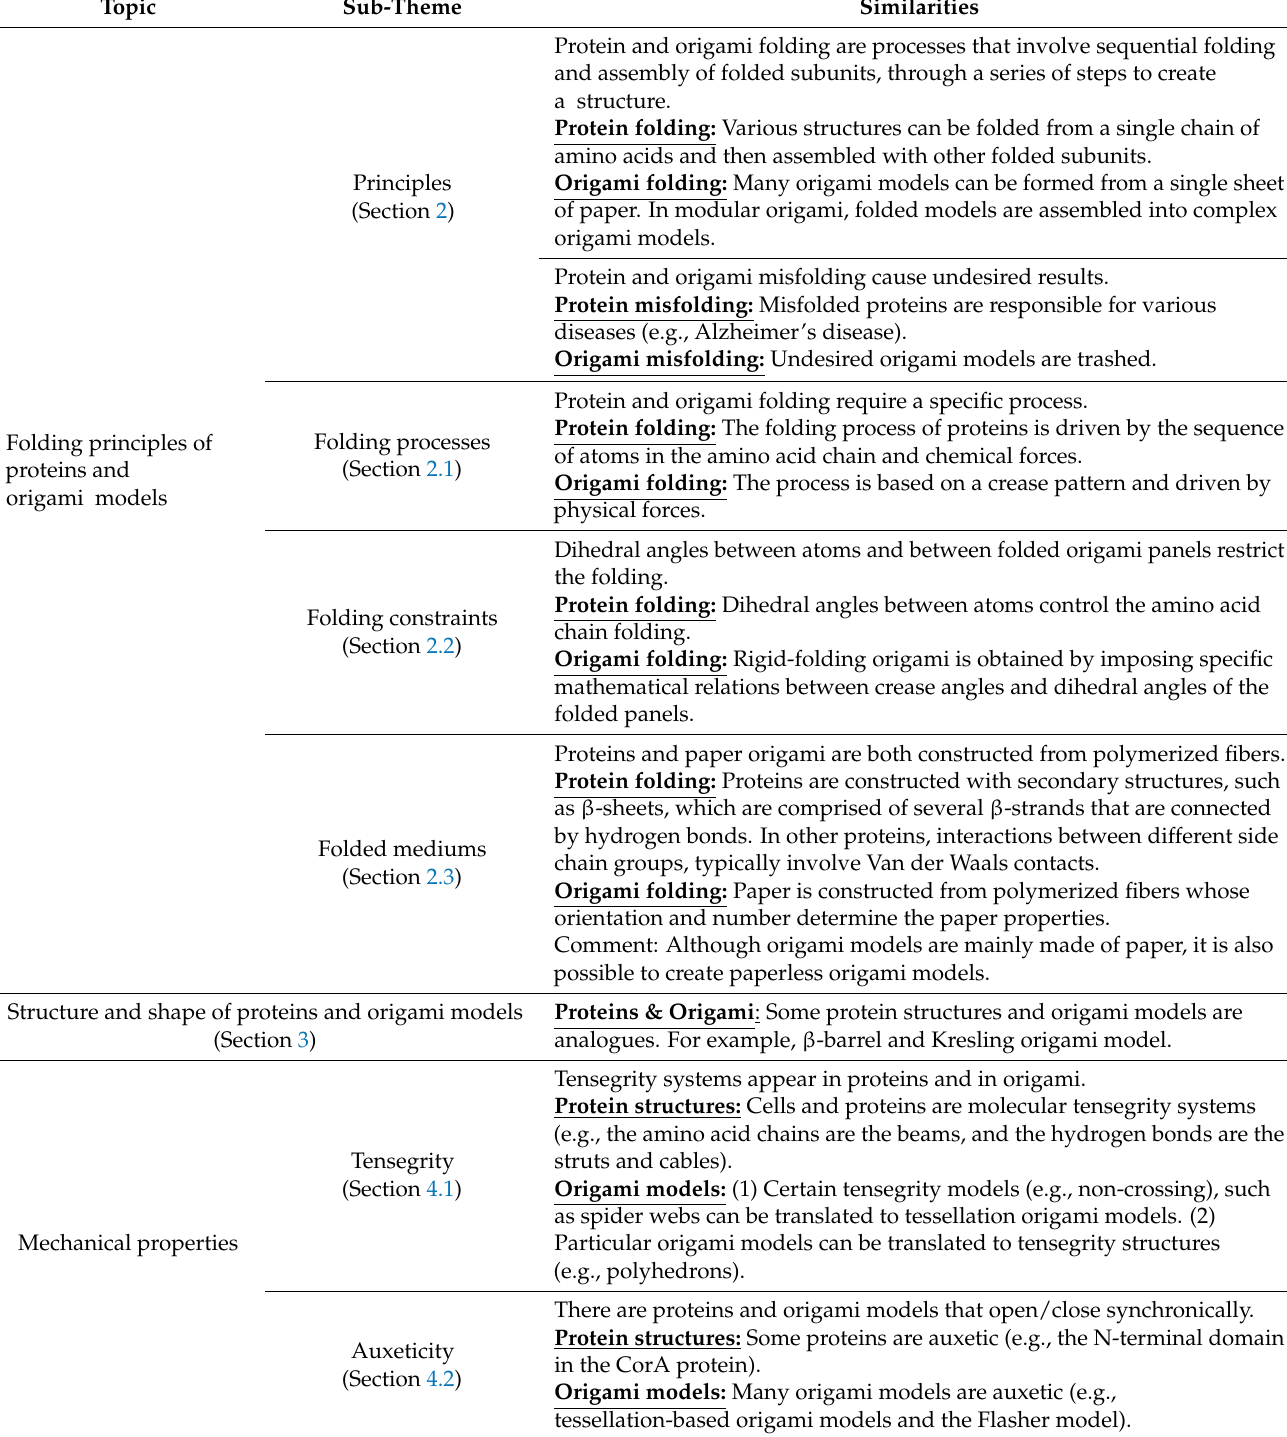
Table 1. Comparison of proteins and origami